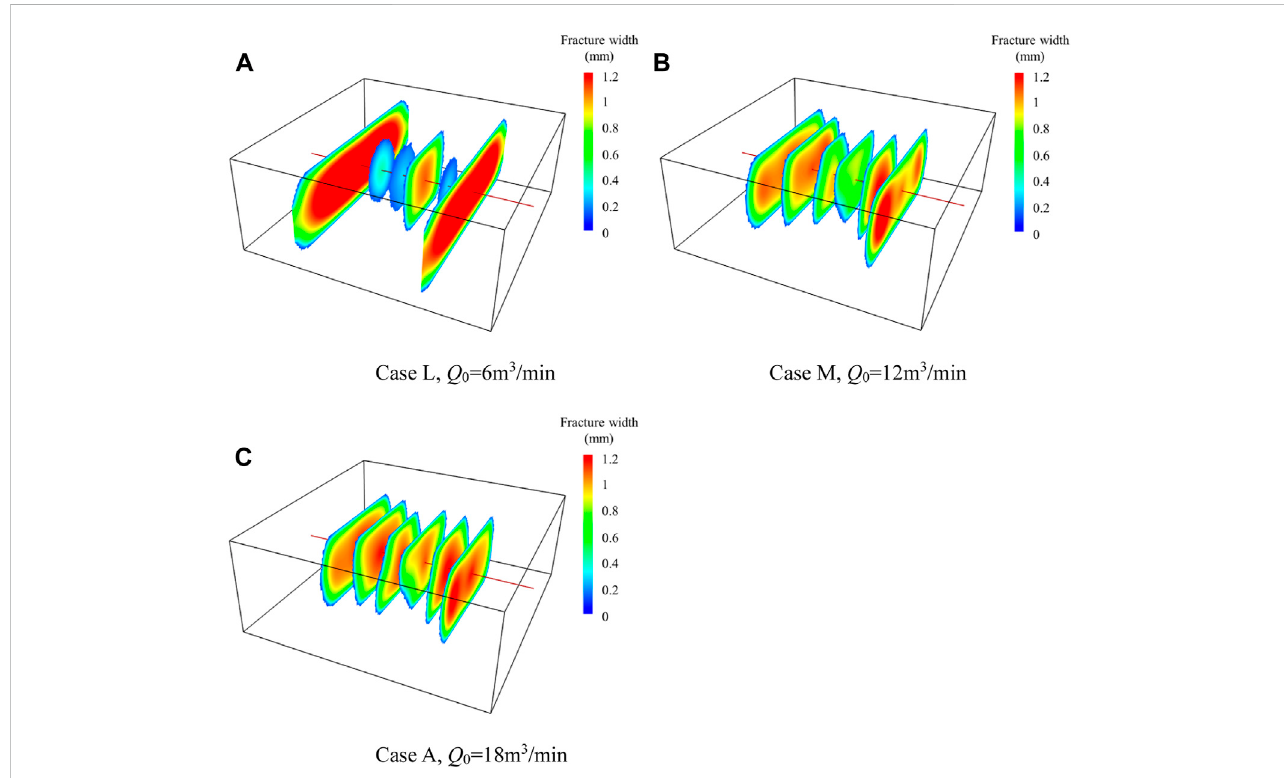
FIGURE 15 Fracture morphology for three cases with different injection rates. (A) Case L, Q 0 = 6 m 3 /min. (B) Case M, Q 0 =12 m 3 /min. (C) Case A, Q 0 = 18 m 3